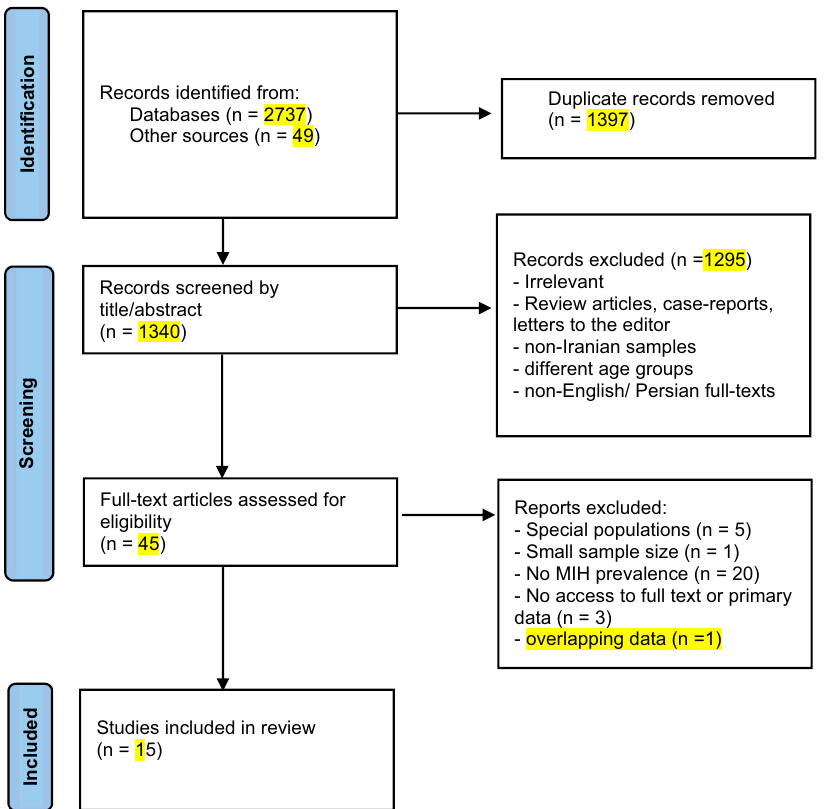
Fig. 1 PRISMA Flow chart. The PRISMA fl ow diagram for the systematic review detailing the study screening and selection process including number of studies screened, number of excluded and retrieved studies, and the reasons for